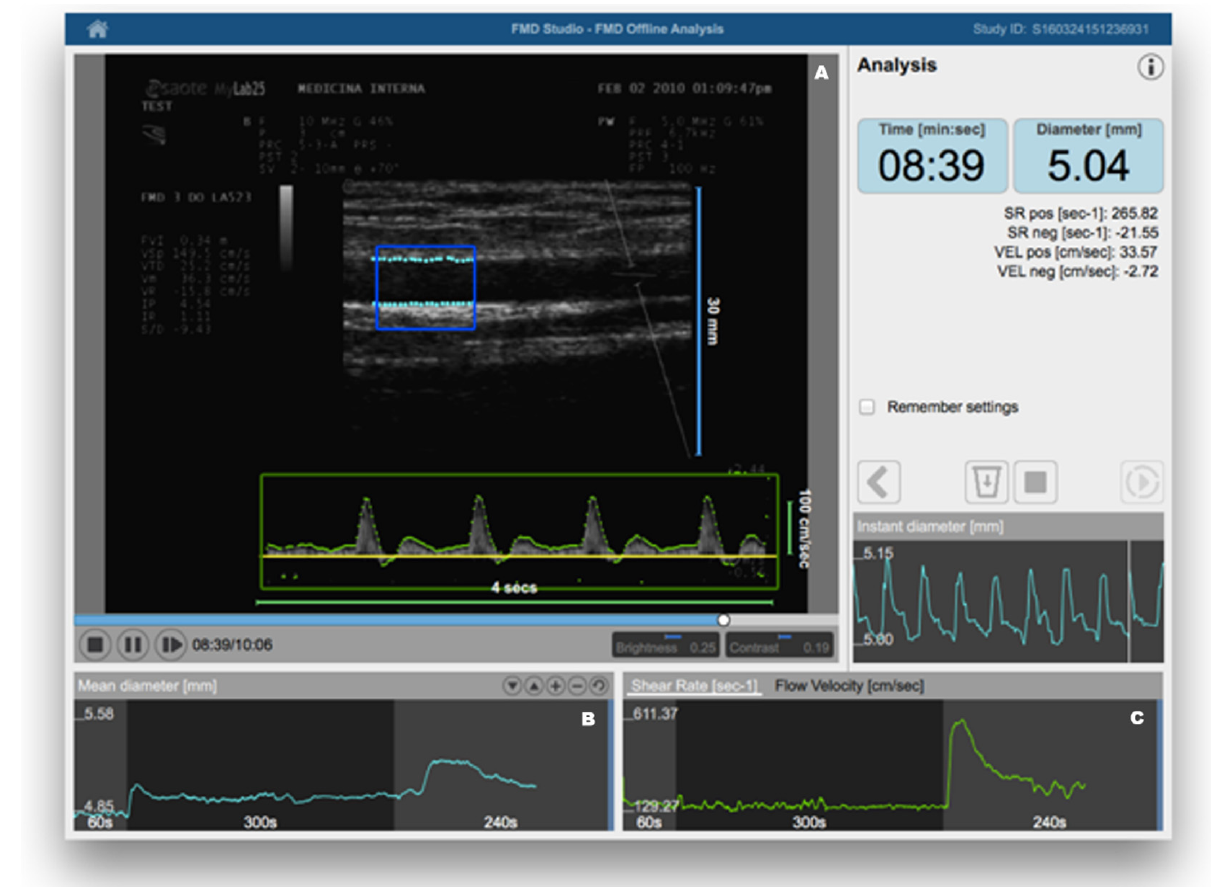
Figure 1. Flow-mediated dilation (FMD) assessment using a Food and Drug Administration (FDA)- cleared software for automatic edge detection (Panel A ), wall tracking (Panel B ), and shear-rate monitoring (Panel C ). Reproduced with permission from Quipu SRL, Pisa, Italy.